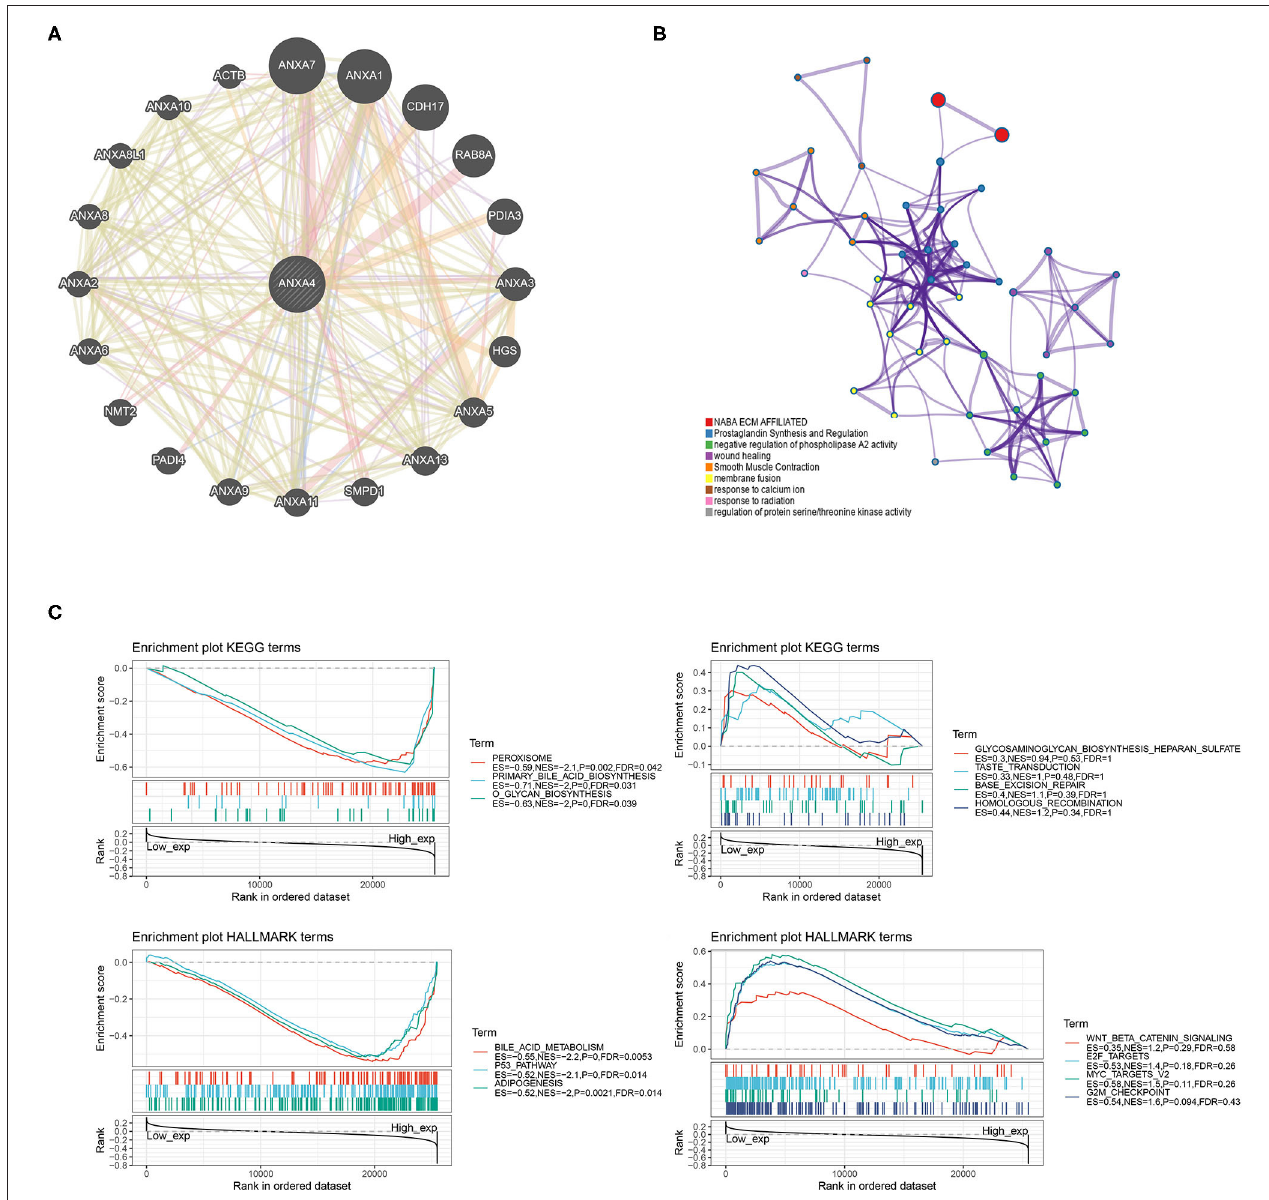
FIGURE 8 | Protein-protein interaction (PPI) network and enrichment analysis (GSEA). (A) Construction of a PPI network with 21 genes centered on ANXA4 . (B) Enrichment analysis using Matescape. (C) Gene set enrichment analysis (GSEA).